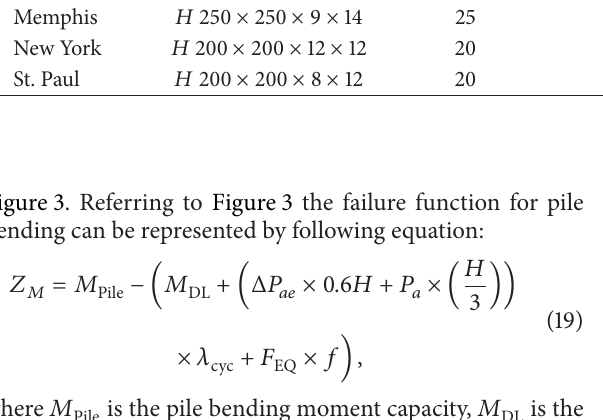
Figure 3. Referring to Figure 3 the failure function for